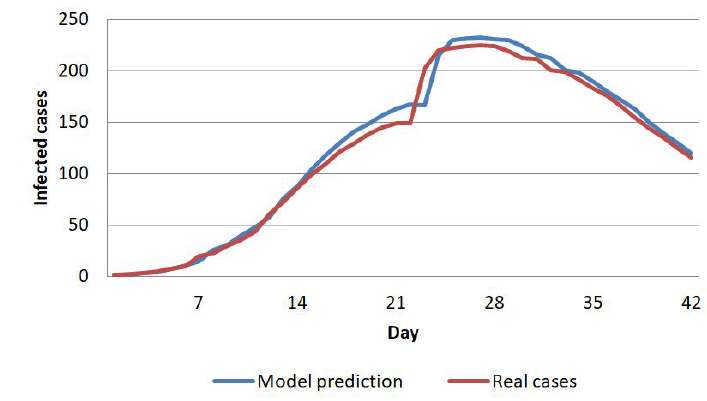
Figure 9. The model fits the real data of cases per cell in China.